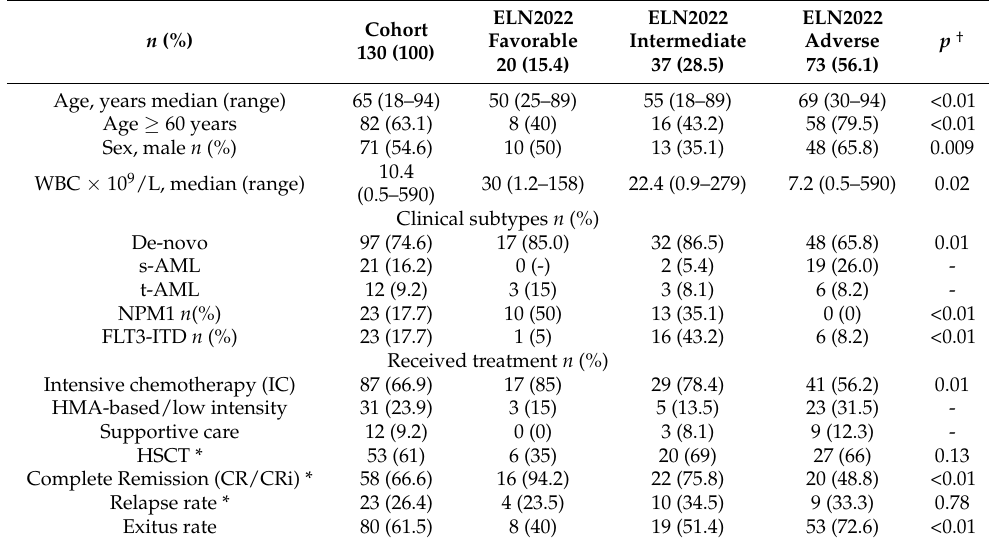
Table 1. Patient baseline, treatment, and prognostic characteristics of the entire cohort according to the ELN2022 risk